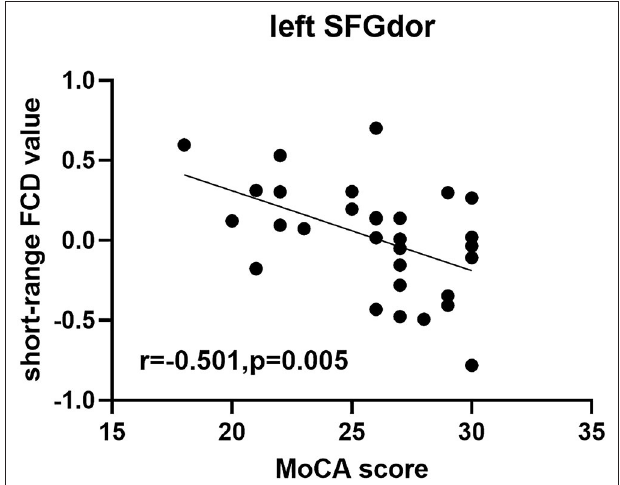
FIGURE 3 | Scatter diagram showing the significant correlation between clinical index and short-range FCD value in the SFGdor in the group with TAO. Short-range FCD value was negatively correlated with the MoCA score ( r = − 0.501, p = 0.005). FCD, Functional connectivity density; SFGdor, dorsolateral part of superior frontal